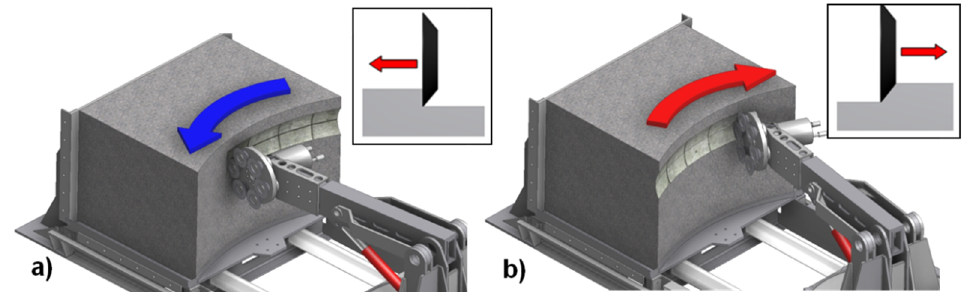
Figure 13. The scheme of horizontal mining of the samples: ( a ) to the left, ( b ) to the right [2,30].